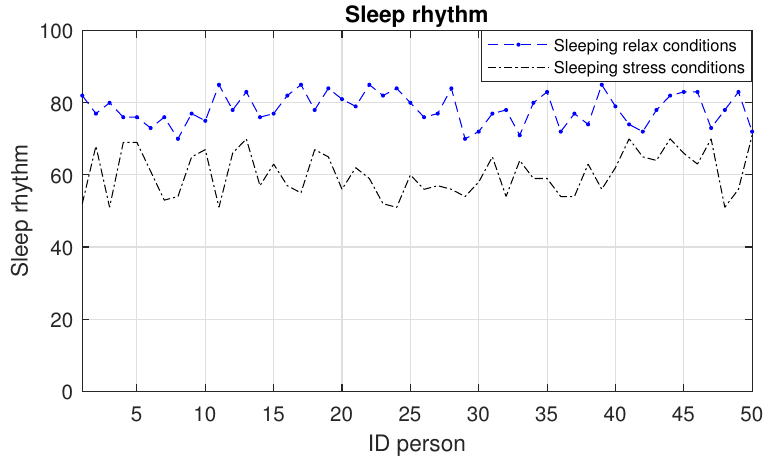
Figure 20. Behavior of sleep rhythm per person under stress and relaxation conditions through the sensor network.